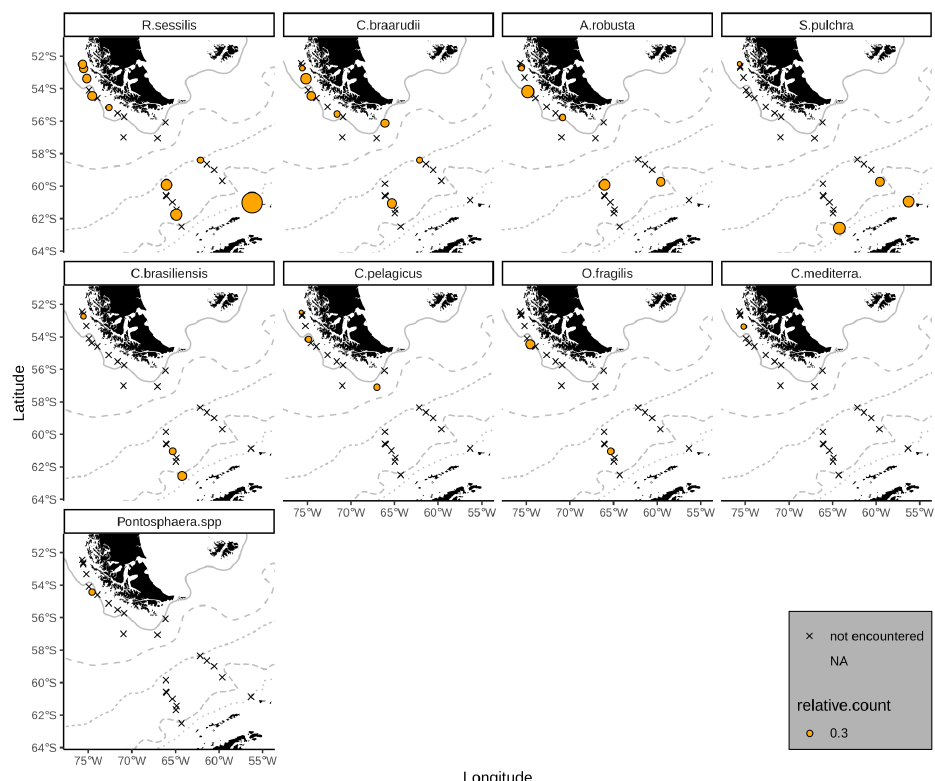
Figure A1. Rare species (abbreviated as C.mediterra. for C. mediterranea ). Dotted and dashed lines depict the ACC fronts as indicated. From north to south: NB, SAF, PF, SACCF and